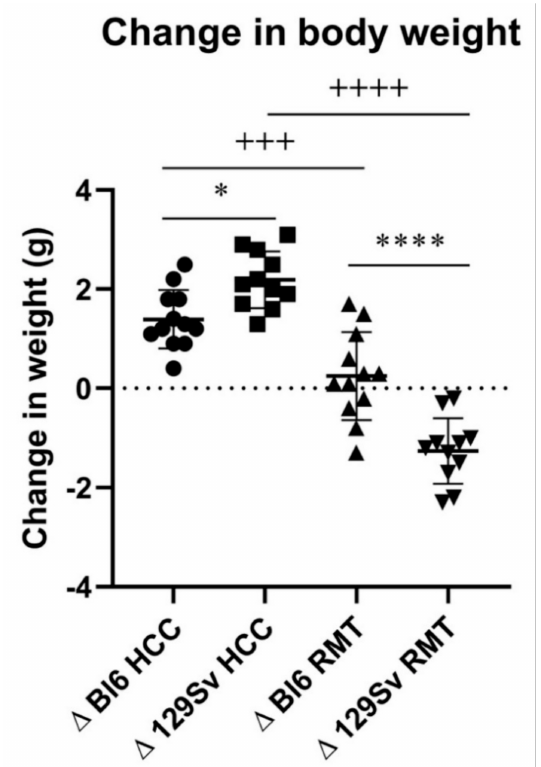
Figure 3. Change in body weight during the experimental period. Two-way ANOVA was applied to demonstrate differences between the strains and environments. Bonferroni post hoc analysis after significant two-way ANOVA: * p ≤ 0.05, **** p ≤ 0.0001 compared to respective 129Sv mice, +++ p ≤ 0.001 and ++++ p ≤ 0.0001 strain specific comparison. Data are expressed as mean values ± SD. Number of animals in each group varied from 12 to